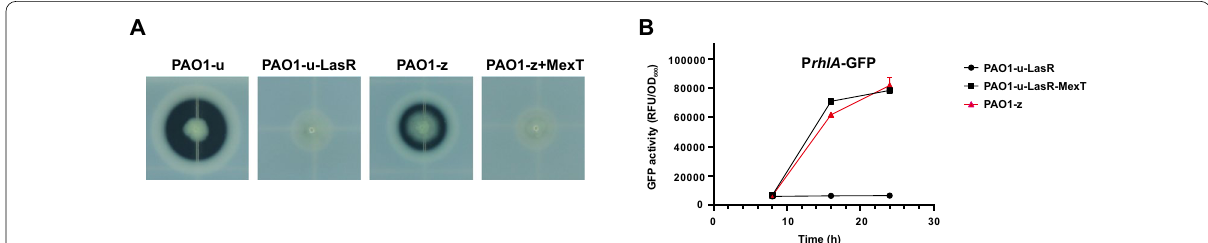
Fig. 2 Inactivating MexT responsible for the active Rhl QS phenotypes in PAO1-z. A Skim milk plate assay of indicated strains. The same amounts of bacteria were spotted onto the skim milk plate and photographed after 18 h incubation. B Detection of fluorescence of P rhlA -GFP reporter in indicated strains. The expression level of GFP in the tested strain was measured by the microplate reader and reported as relative fluorescence units (RFU). PAO1-u-LasR, PAO1-u strain with deleting the full-length of the lasR gene; PAO1-z MexT, PAO1-z strain was complemented with a construct + expressing the mexT gene from the PAO1-u strain; PAO1-u-LasR-MexT, PAO1-u strain with deleting both of the lasR and mexT